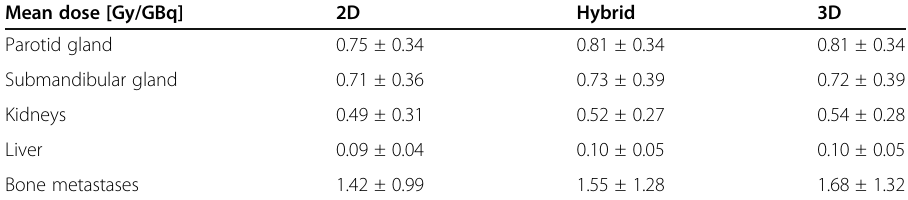
Table 2 Mean absorbed dose per administered activity [Gy/GBq] in normal tissues and bone metastases estimated by the three dosimetry methods Mean dose [Gy/GBq] 2D Hybrid 3D Parotid gland 0.75 ±